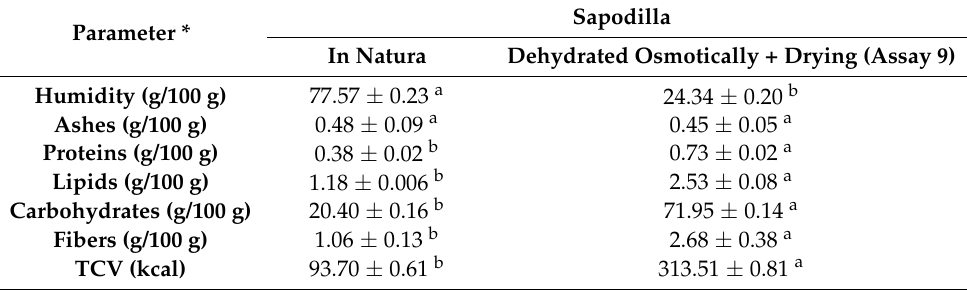
Table 7. Centesimal composition of in natura and osmotically dehydrated sapodilla.